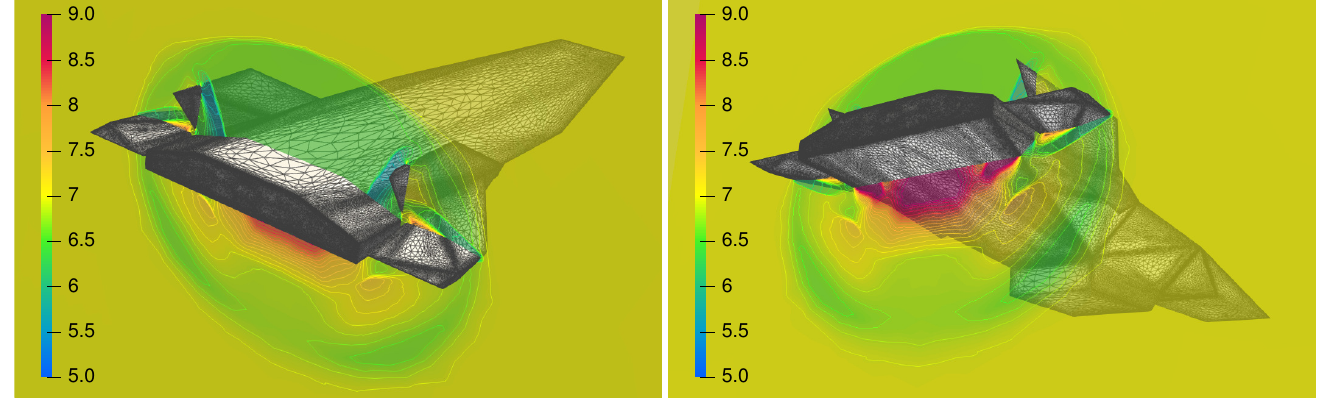
Figure 20. X43a Mach number contours at 95% of